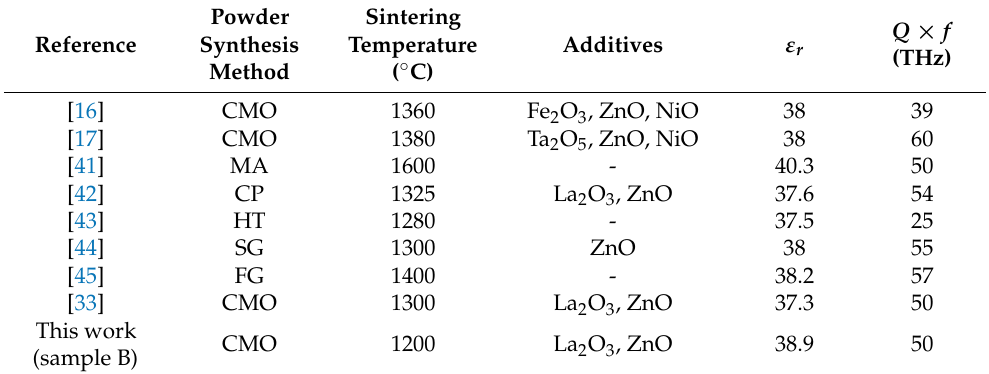
Table 3. MW dielectric properties of ZST ceramics in the literature compared with those reported here.